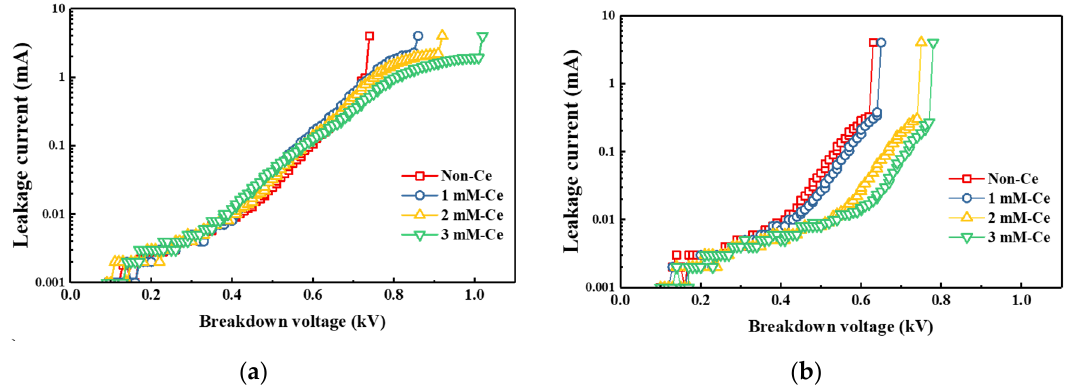
7 of 10 Figure 7. Etching rate of AAO film after CF 4 /Ar/O 2 plasma exposure for 1 h. The input power increased because of an increased plasma density and a reduction in the line width during semiconductor etching. In this case, the insulation characteristic of the AAO film was important because insulator-film breakdown occurs easily because of the high voltage when a high power is applied. Figure 8a shows the measurement results of the breakdown voltage according to